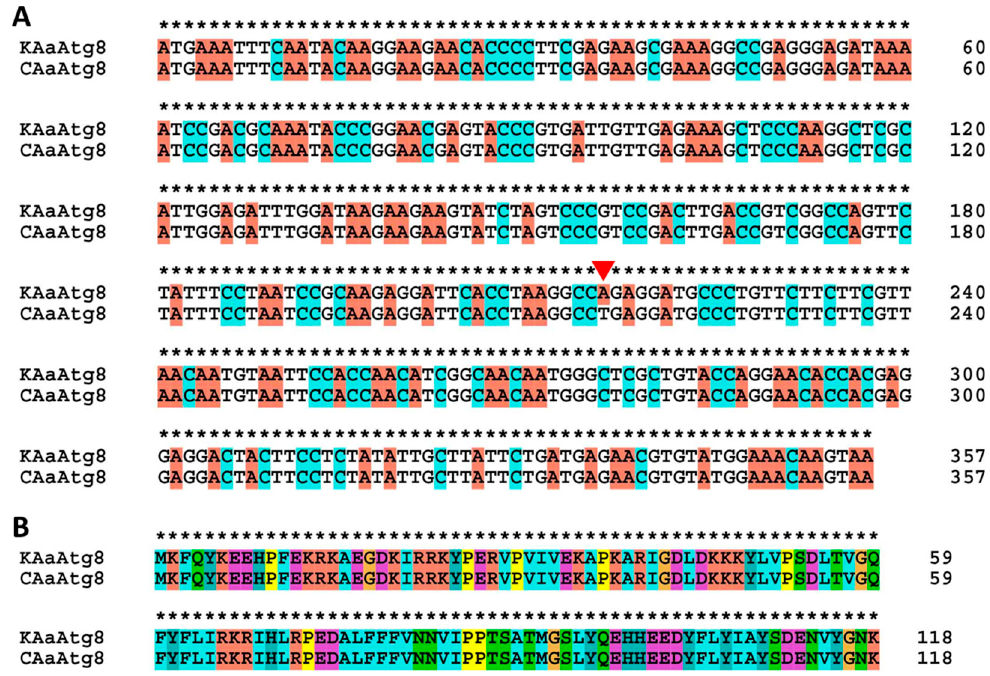
Figure 2. Comparative analysis of the AaAtg8 gene identified from the Ae. albopictus Korean ( KAaAtg8 ) and Chinese strains ( CAaAtg8 ) at the nucleotide ( A ) and amino acid sequence ( B ) level. The pairwise alignment results show a single nucleotide mismatch (marked by a red triangle). However, the mismatch of A 216 in KAaAtg8 to T 216 CAaAtg8 does not alter the expected protein sequence.